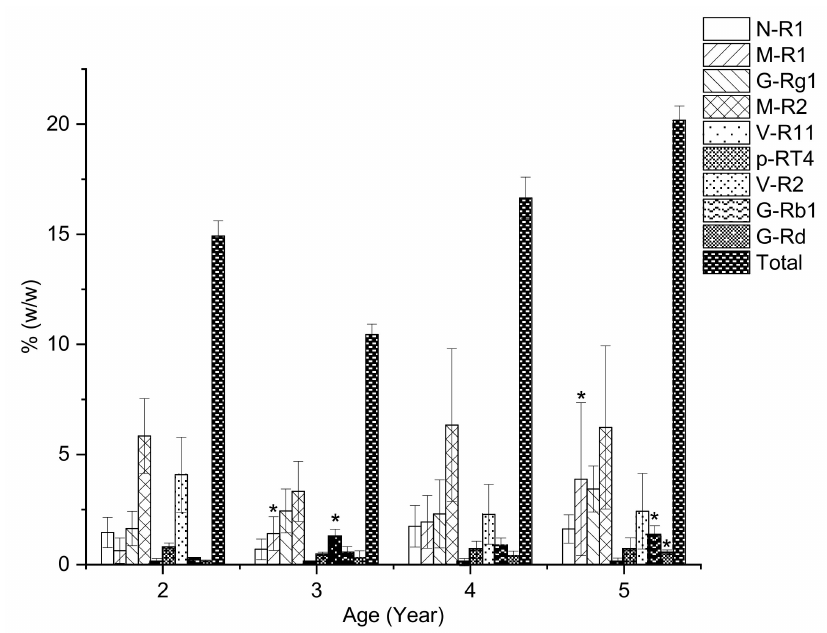
Figure 4. The change of saponin content in 2–5 years old VG main roots analyzed by HPLC–CAD. Results are expressed as mean ± SD ( n = 5). * p < 0.05 compared with the age of 2.